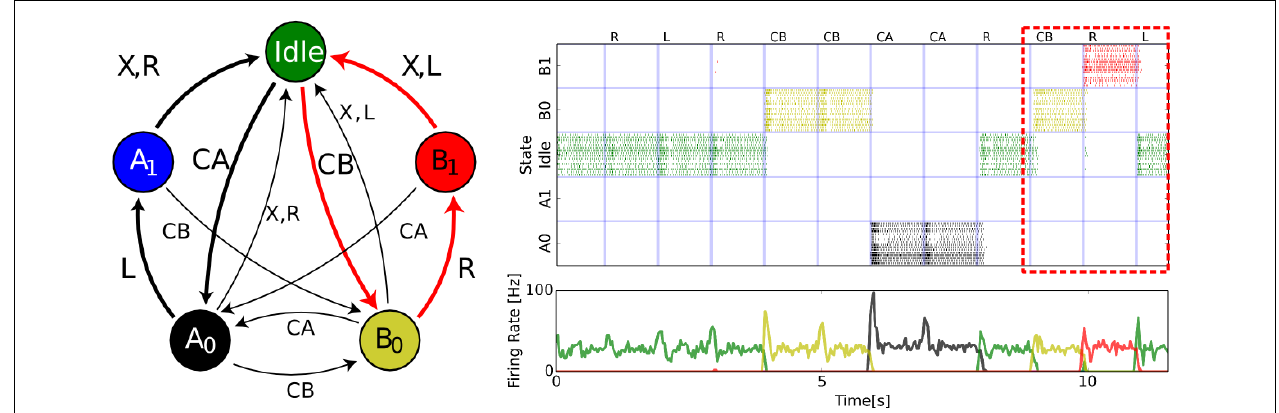
FIGURE 4 | Soft State Machine implemented in neuromorphic hardware. (Left): State machine description of a cognitive task (Neftci et al., 2013). Each state is represented by a circle and each arrow is a possible transition given the annotated symbol. The symbol × reflects an “invalid” cue and resets the state to “Idle.” The spiking neural network architecture underlying the SSM is composed of three sWTA circuits: a state sWTA that maintains the state in persistent activity (32 neurons per state), a transition sWTA that mediates the transitions between states